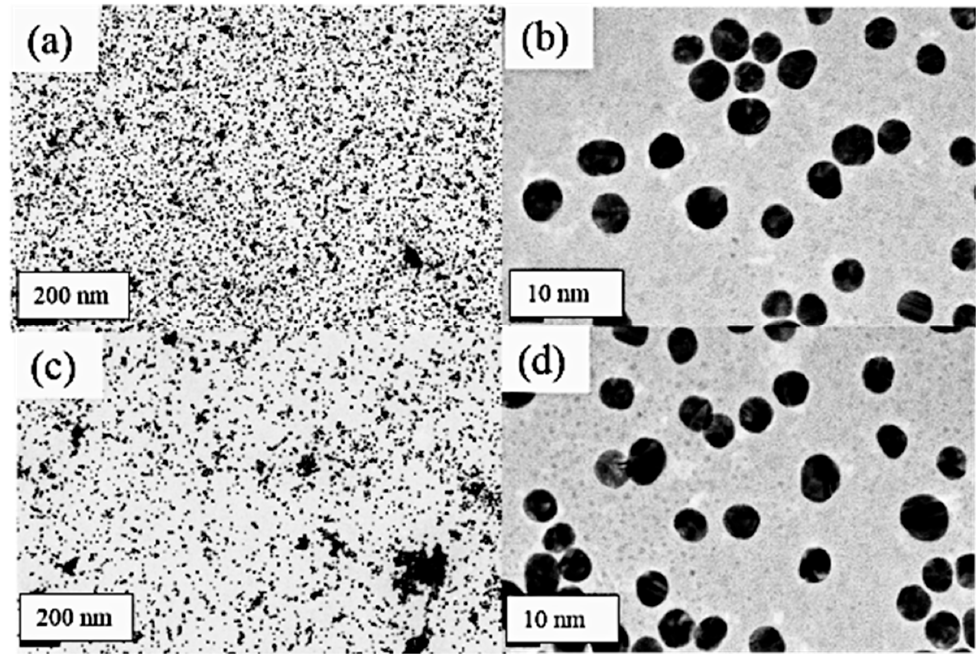
Figure 8. Transmission electron microscopy images of gold nanoparticles. ( a ) Control-200 nm, ( b ) control-10 nm, ( c ) 47 mM APTES-200 nm, and ( d ) 47 mM APTES-10 nm.